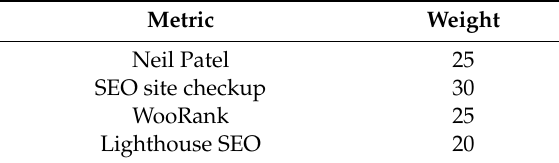
Table 7. Weights for the calculation of the SEO performance evaluation